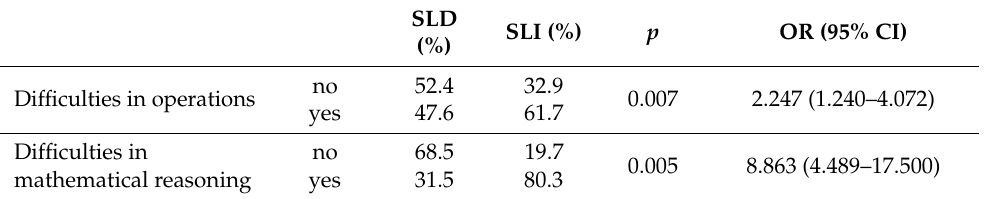
Table 6. Results of chi-square test and odds ratio for operations difficulties with respect to